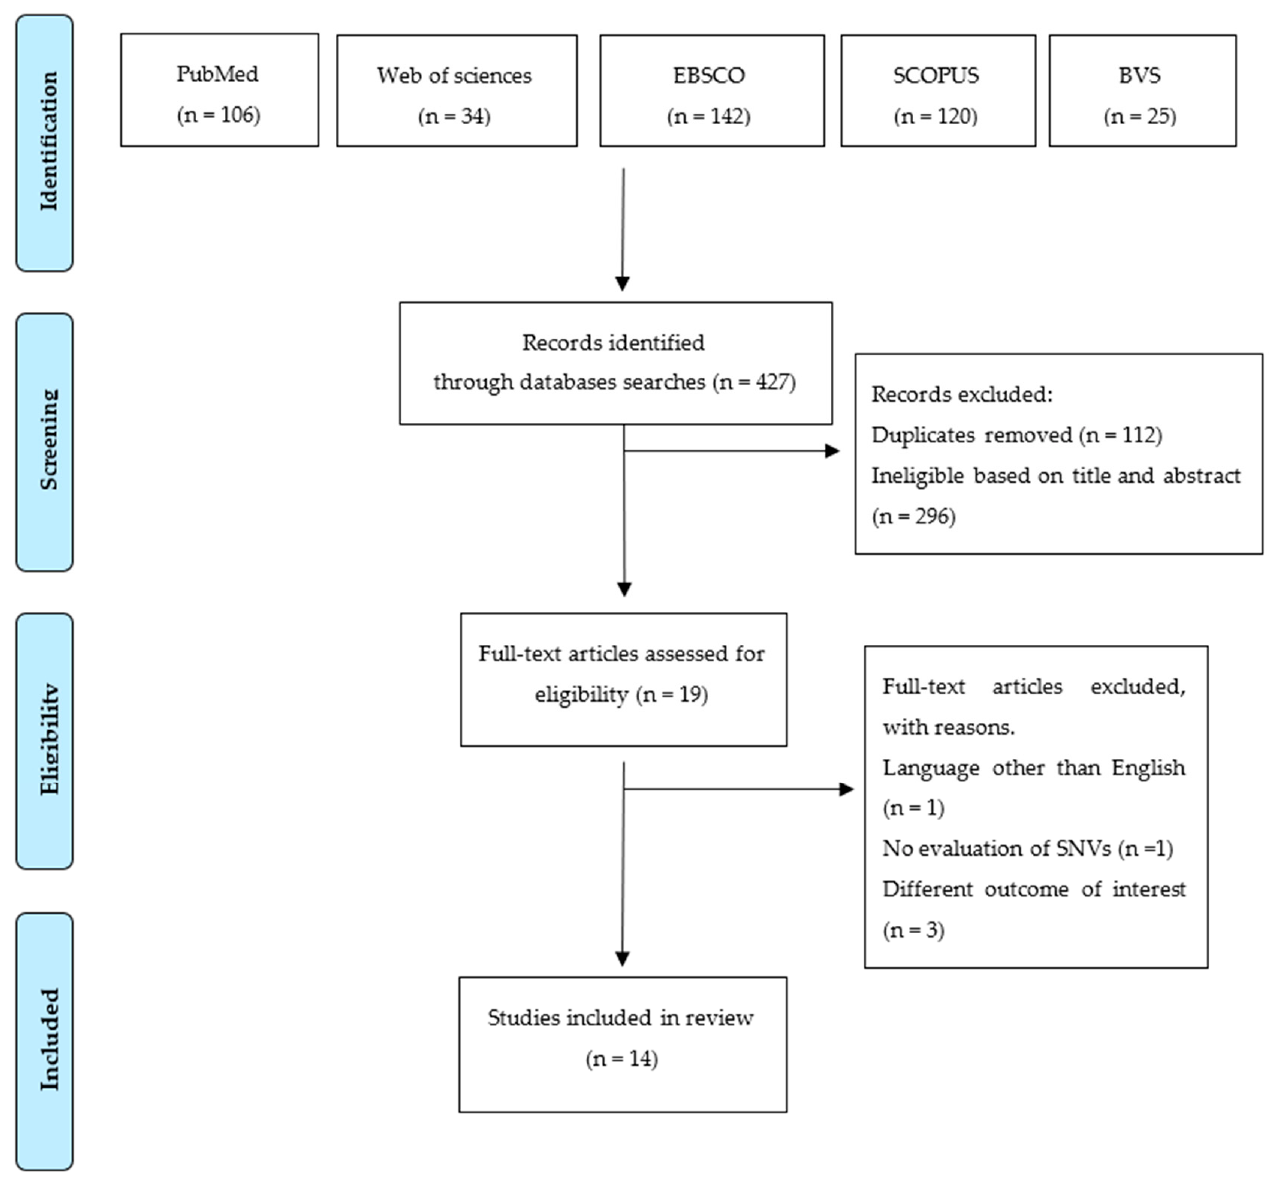
Figure 1. PRISMA 2020 flow chart describing the screening process.